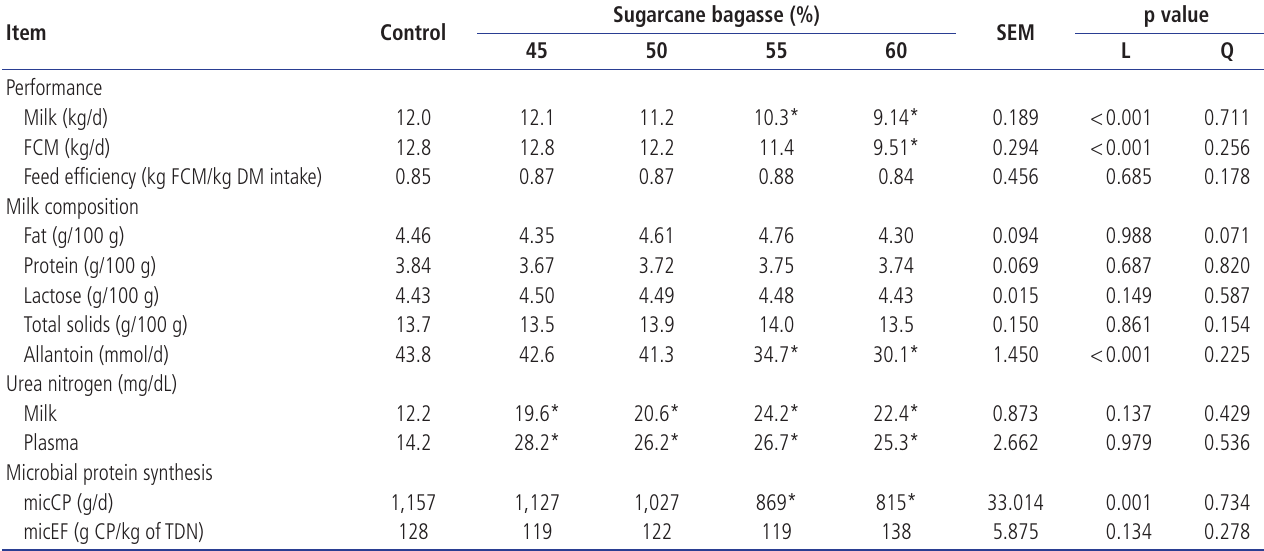
Table 5. Performance, milk composition, blood and milk urea nitrogen and microbial protein synthesis of cows fed sugarcane bagasse